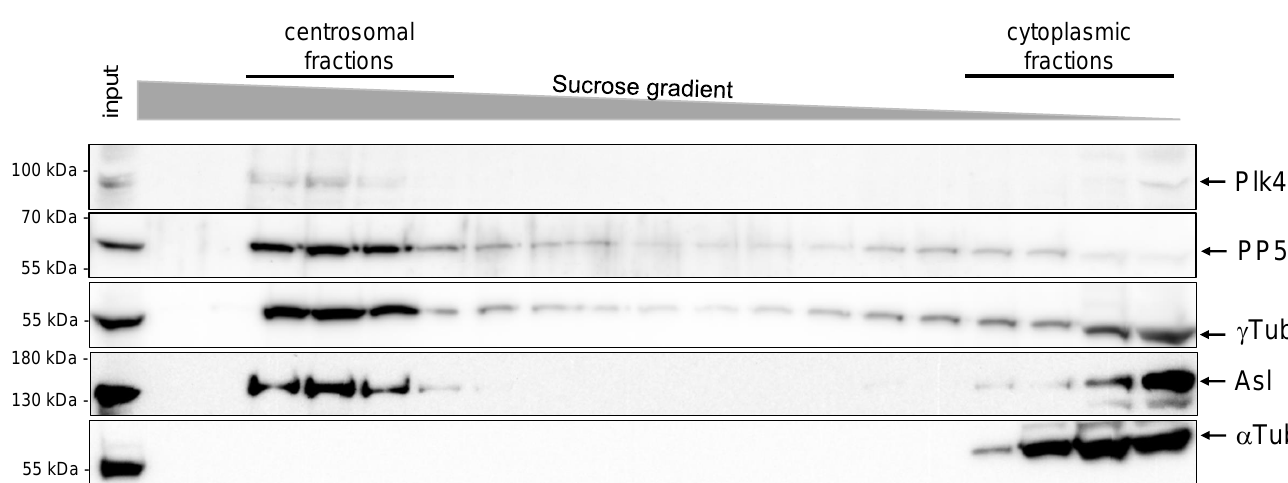
Figure 6. PP5 and Plk4 co-migrate with centrosomal proteins. A western blot analysis of the centrosomal and cytoplasmic fractions of proteins that were prepared from Drosophila syncytial embryos by sucrose gradient ultracentrifugation. Endogenous proteins were revealed by specific- antibodies (indicated on the right), which shows that PP5 co-fractionated with Plk4, as well as with the centrosomal markers Asl and γ Tubulin ( γ Tub). α Tubulin ( α Tub) represents the cytosolic